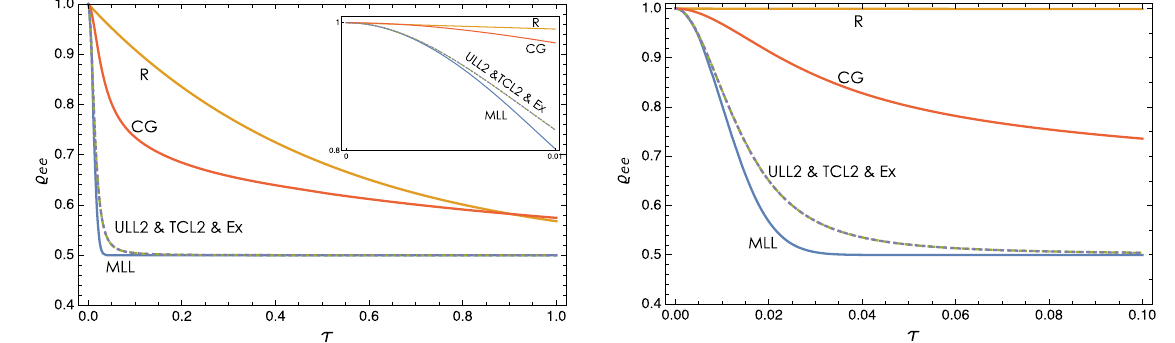
2. A qubit in a bosonic bath. Left panel: Population of the excited state of the two-level system as a function of time for β ¼ 1 , η ¼ 0 . 5 , ω 100 , and ω 0 (all in dimensionless units), where the two-level system is initially in the excited state. The labels TCL2 0 ¼ c ¼ & Ex, MLL, ULL2, CG, and R denote, respectively, the data from the second-order time-convolutionless ( ¼ Exact), MLL, time-local ULL2 ( ¼ Exact), coarse-graining, and the Redfield ( ¼ Markovian Lindblad) solutions. The inset is a magnified depiction of the population vs time for short times. Right panel: The same as the left panel but for β ¼ 100